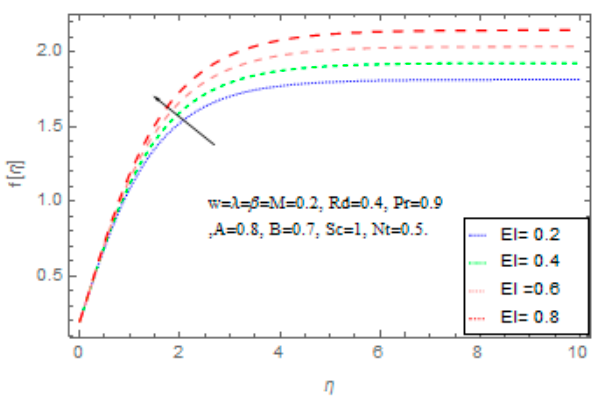
Figure 13. Influence of EI on velocity profile.